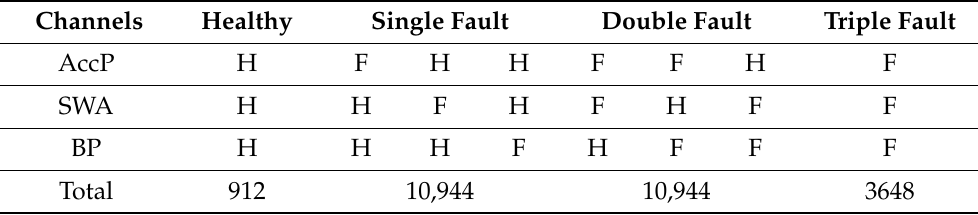
Table 4. Number of signals in all of the faulty/healthy combinations.